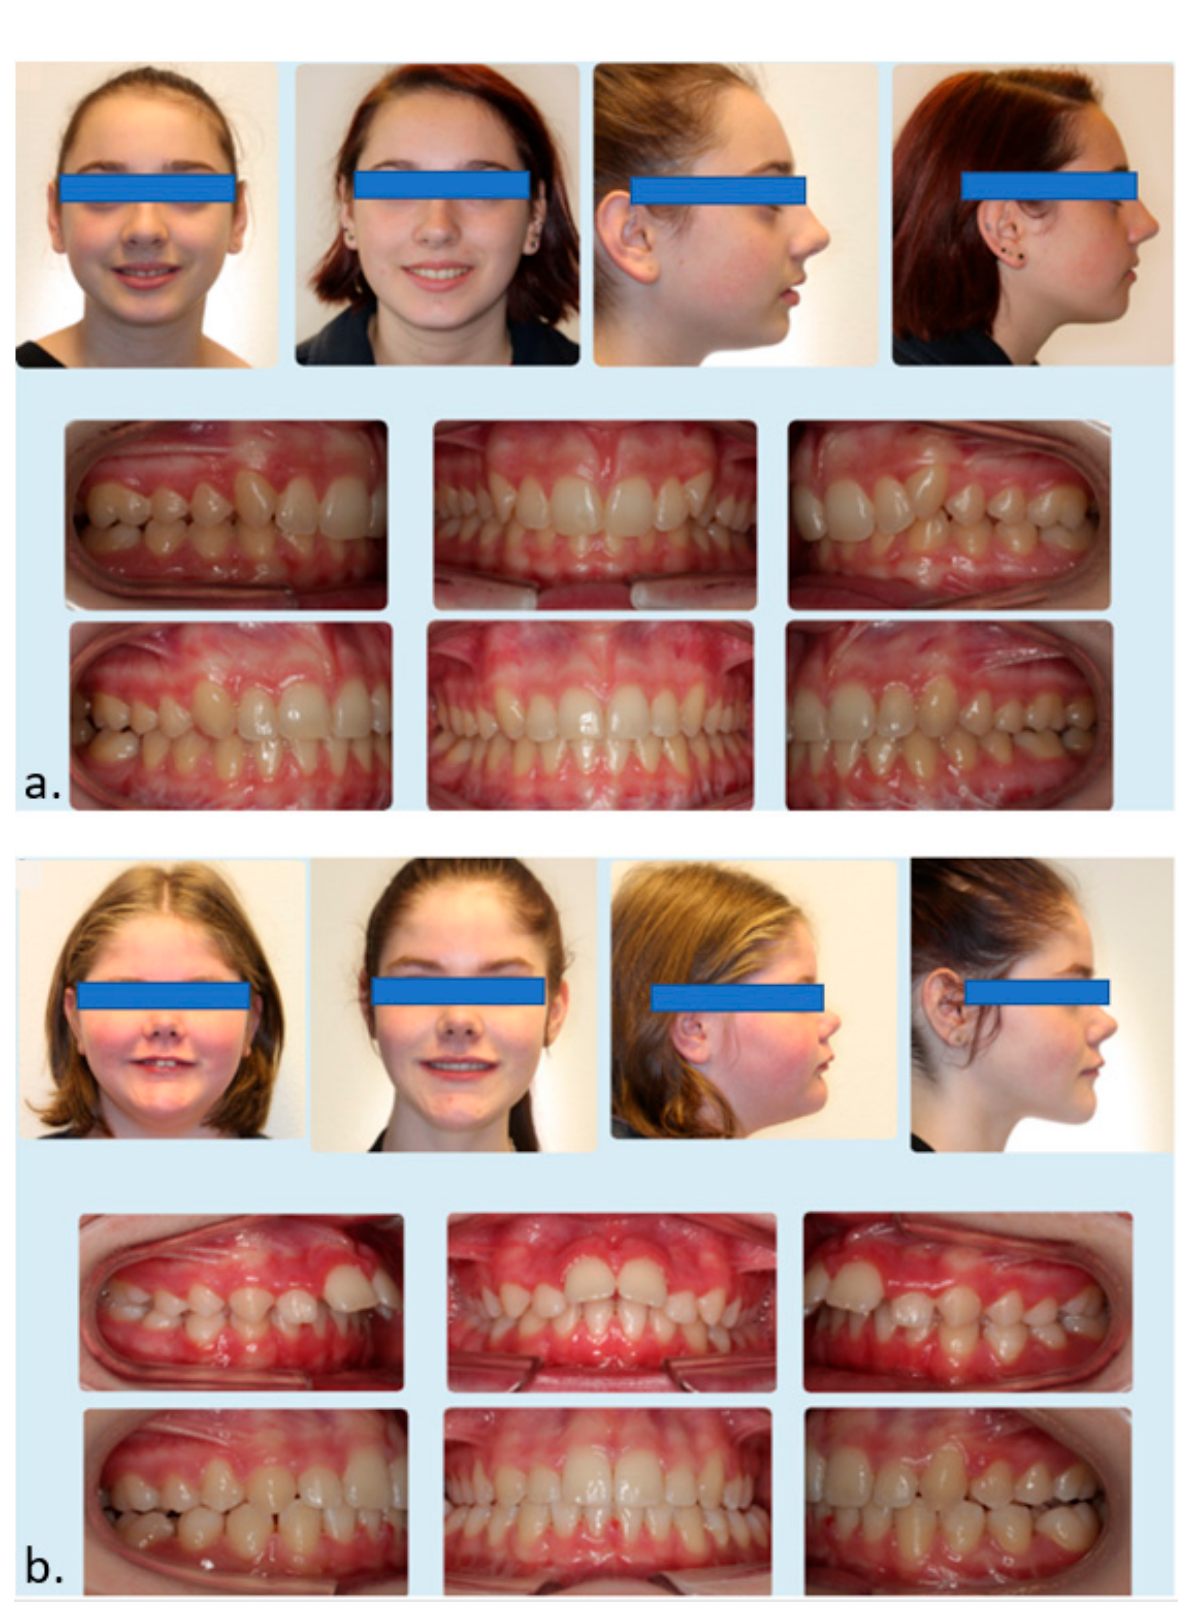
Figure 5. Clinical follow-up. Photographic documentation of two patients: ( a ) 12-year old patient with class II/2 occlusion before and after end of combined orthodontic and IMDO treatment. ( b ) 12-year old patient with class II/1 occlusion and traumatic deep bite before and after end of combined orthodontic and IMDO treatment.